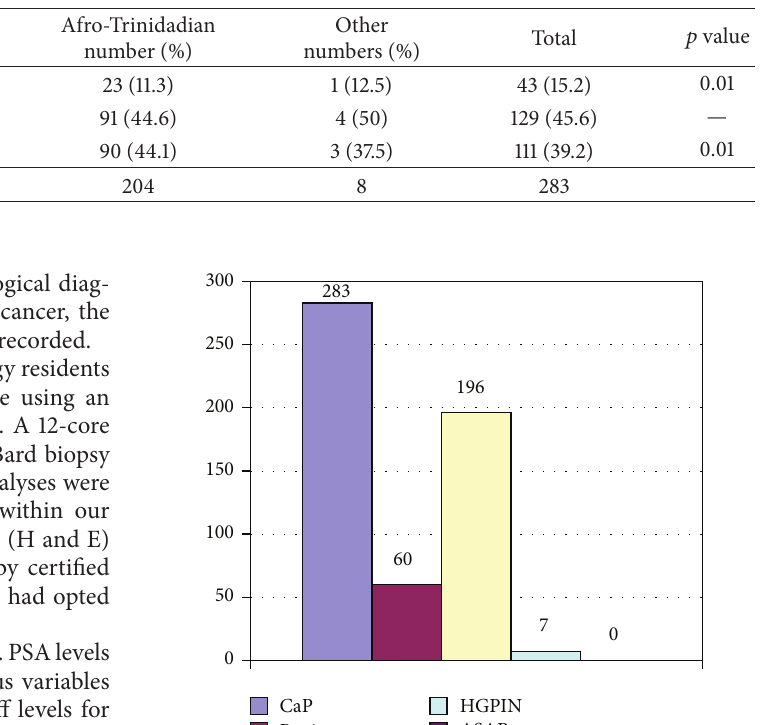
Table 1: Distribution of cancers by tumor differentiation.